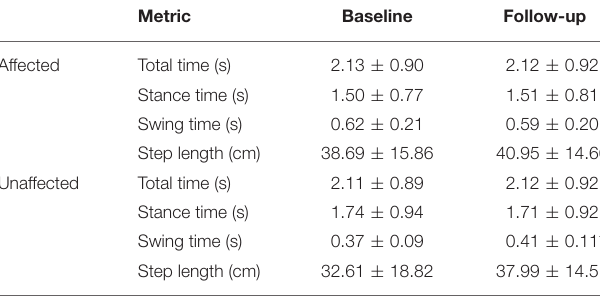
TABLE 4 | Temporal and spatial characteristics ( n =